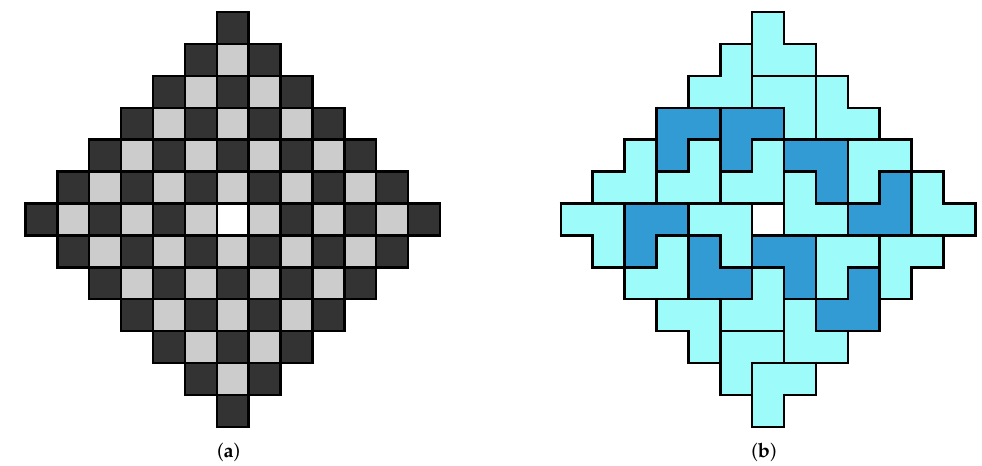
Figure 17. Target region and a tiling solution for Example 5: ( a ) The target region (cid:98) R , a checkerboard coloured diamond shaped region with a single ‘hole’ in the middle; ( b ) Successful tiling of the target region (cid:98) R using 28 copies of an L-shaped trimino. The 20 pariominoes P + are coloured light-blue 1 and the 8 pariominoes P − are coloured dark-blue, corresponding to an optimal solution of the single 1 pariomino tiling